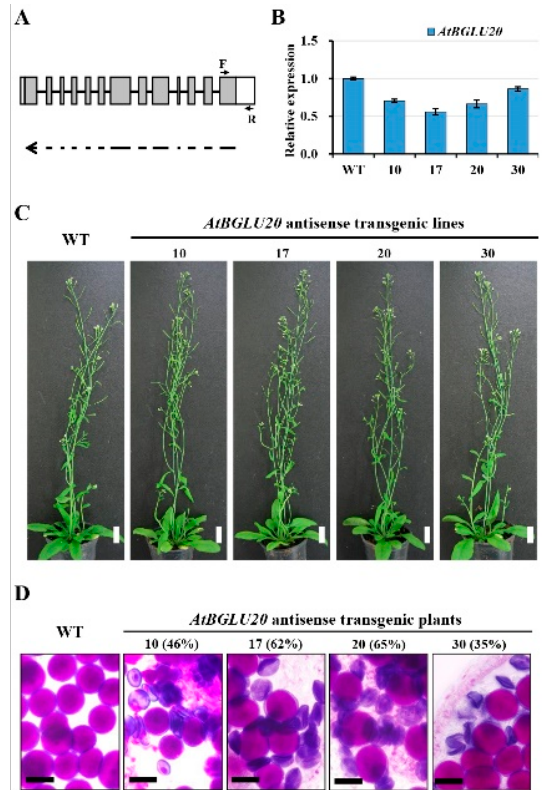
Figure 5. Analysis of WT and AtBGLU20 antisense knockdown mutant Arabidopsis plants. A . Schematic representation of the AtBGLU20 gene structure and DNA fragment regions for antisense constructs. The white box indicates the UTR region; gray boxes are exons; lines represent introns. The single arrow indicates the antisense orientation of the fragments in the constructs. F and R indicate the